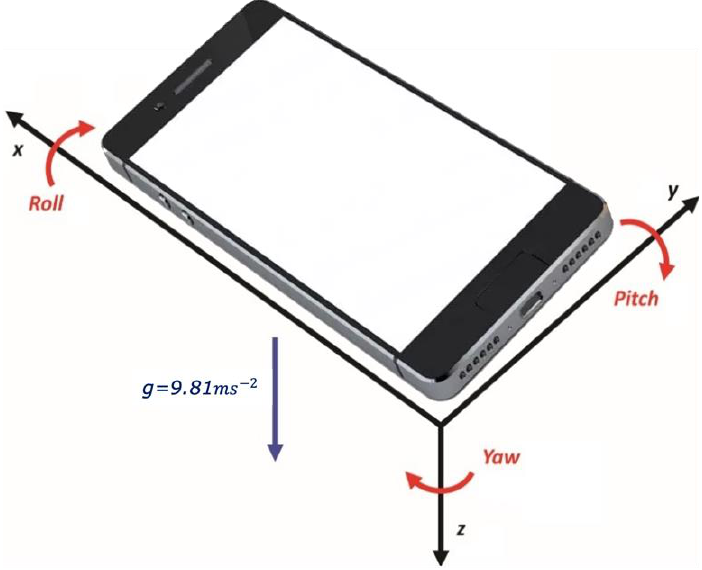
Figure 2. Getting Roll, Pitch, and Yaw data from the device.